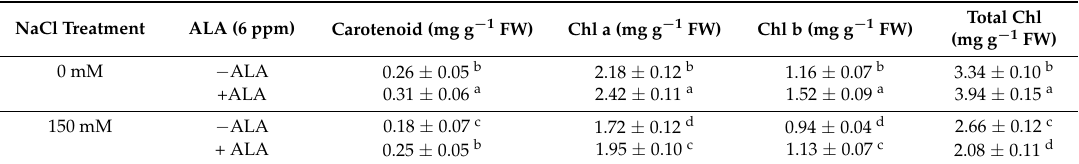
Table 5. Contents of chlorophyll and carotenoid in the leaves of the Elatius 3 cultivar following salinity (150 mM NaCl) and 5-aminolevulinic acid ([ALA], 6 ppm)